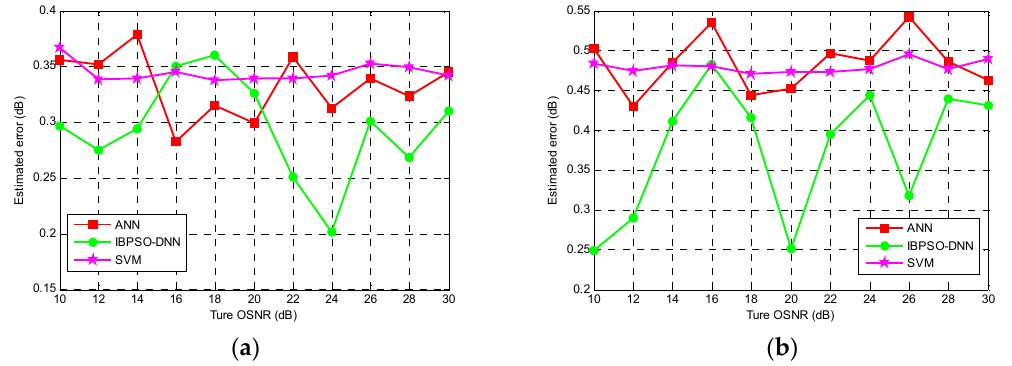
Figure 11. True versus estimated OSNRs and errors for PM-NRZ-16QAM signal with ( a ) 100 bin numbers and ( b ) 65 bin numbers using PSO-DNN in different OSNRs.